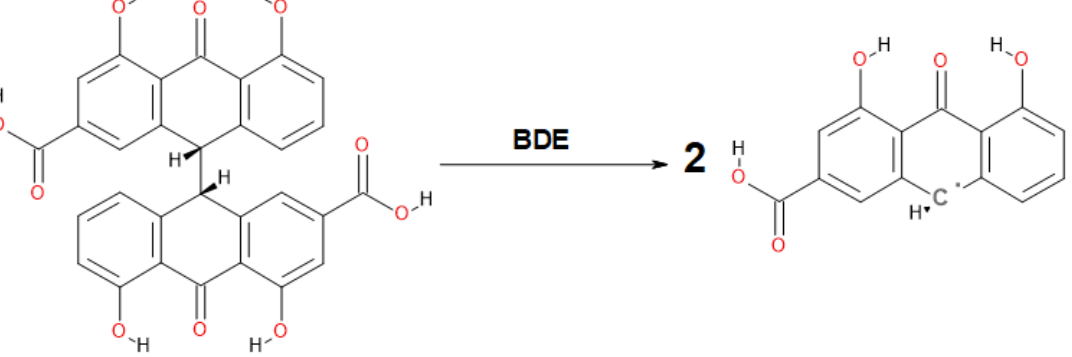
Figure 9. ACID isosurfaces for selected sennidin structures: ( a ) structure 1, ( b – d ) structure 4. ACID isosurfaces have been calculated at value of 0.05.